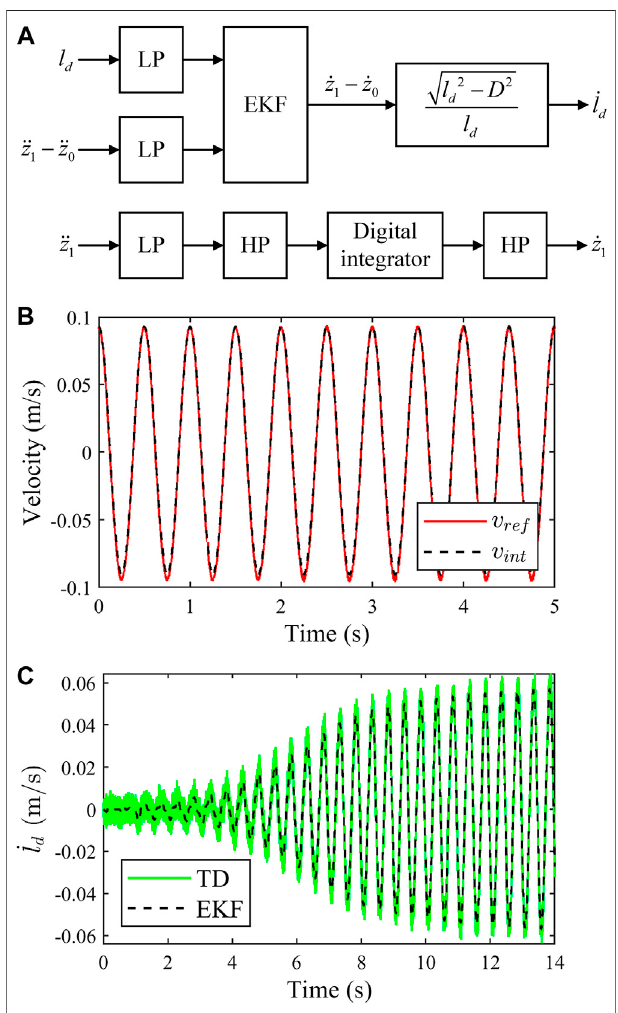
FIGURE 10 | The signal processing diagram and results: (A) the signal processing diagram; (B) acceleration signal integration results; and (C) EKF signal fusion